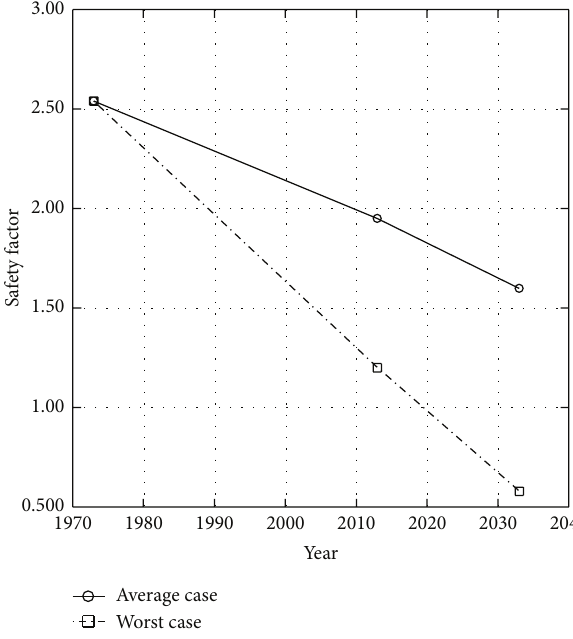
Figure 25: Safety factor for plate element with 600 mm depth and reinforced with 19 mm diameter rebar at 150 mm spacing. Figure 26: Safety factor for wall element with 600 mm depth and reinforced with 22mm diameter rebar at 150 mm spacing.